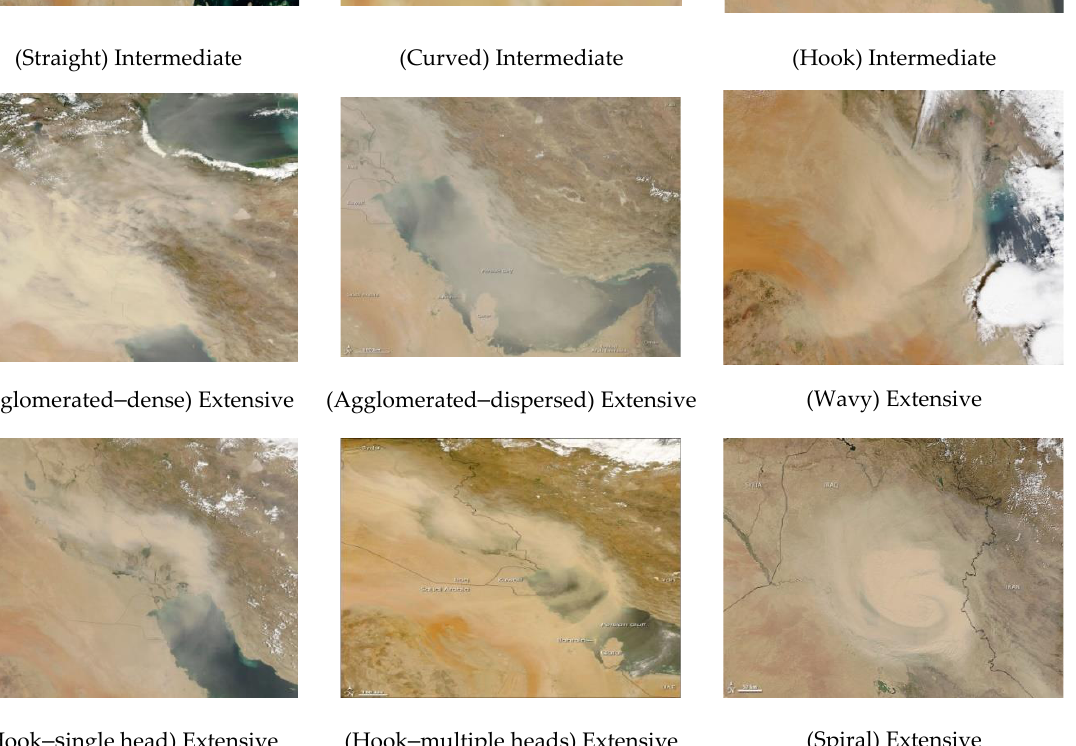
Figure 5. Sorting record of SDS in reference to sand and dust storms width (3 main form types containing 12 sub-forms).